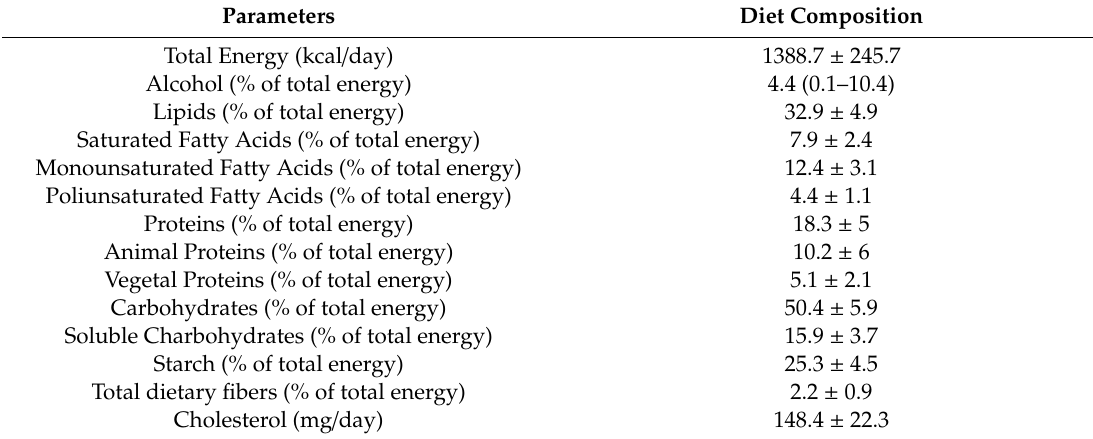
Table 3. Diet composition and total fiber intake (g / day) at the enrollment. Values are reported as mean ± SD or mean and variation